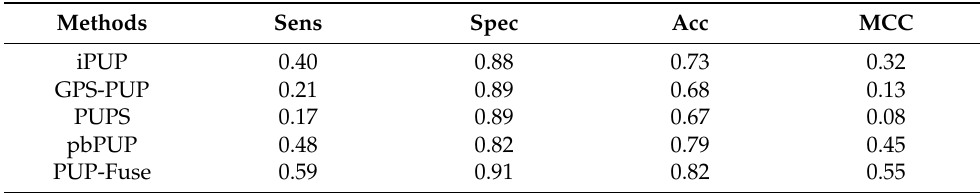
Table 3. Performance comparison of the PUP-Fuse with the four existing methods on the independent